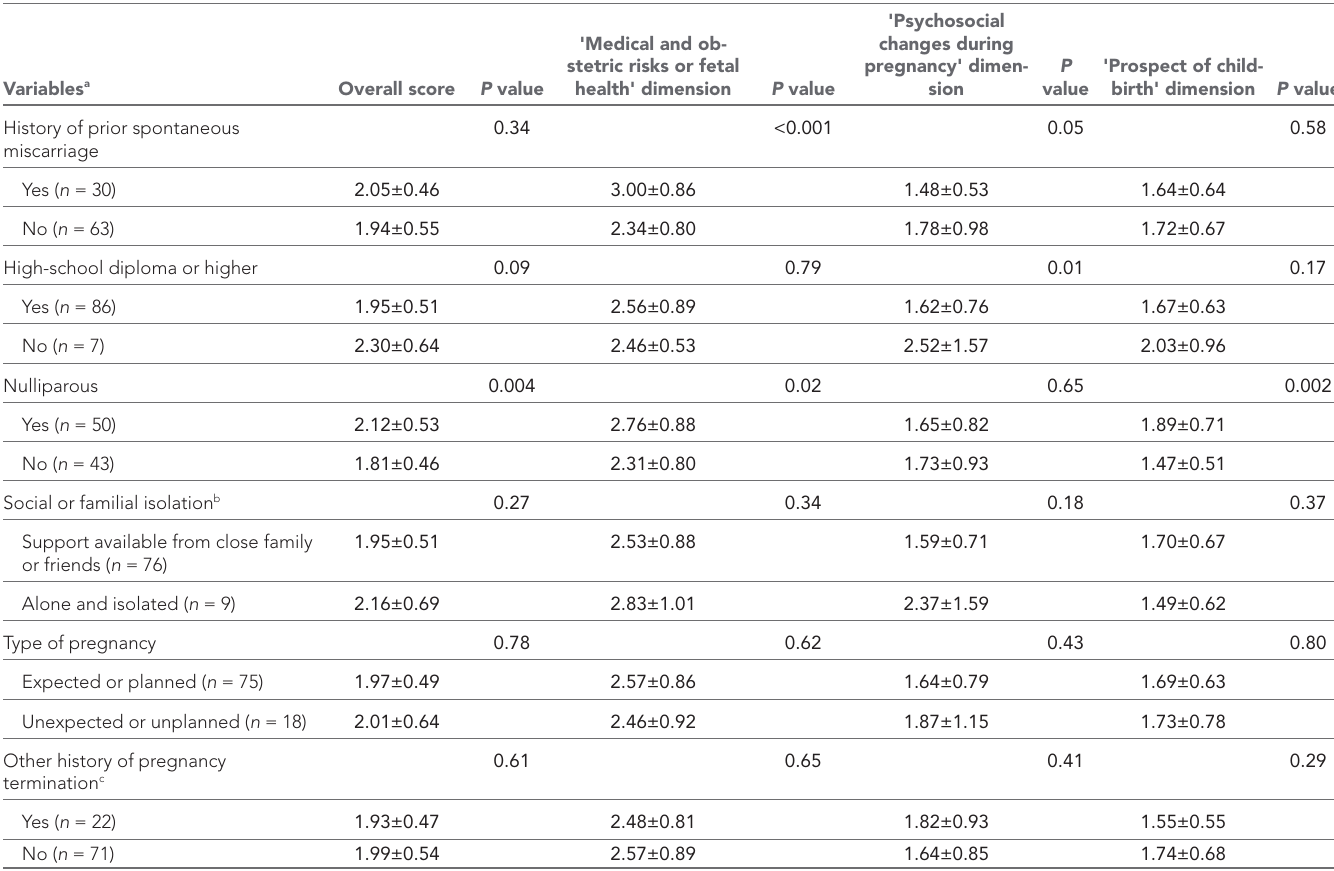
Table 3 Univariate analysis of the factors associated with maternal stress among pregnant women (in the first trimester of pregnancy) as evaluated by the Antenatal Perceived Stress Inventory (overall score and for each of the three